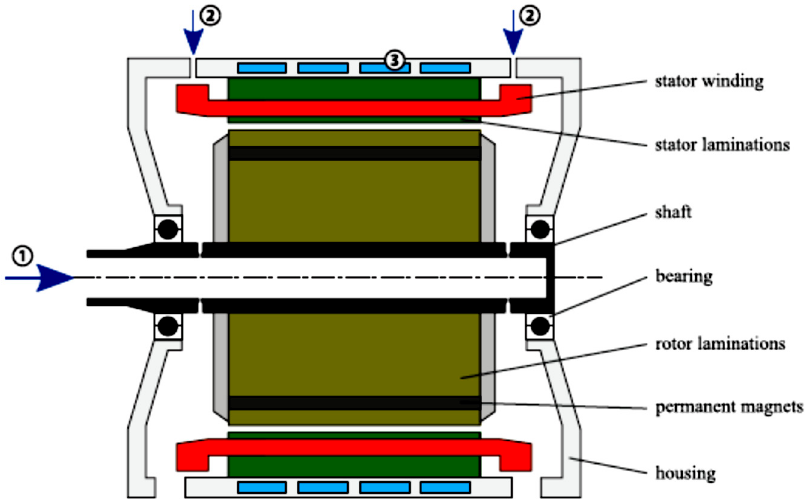
Figure 21. Direct oil injection into the shaft, housing and cooling jacket—schematic [66].